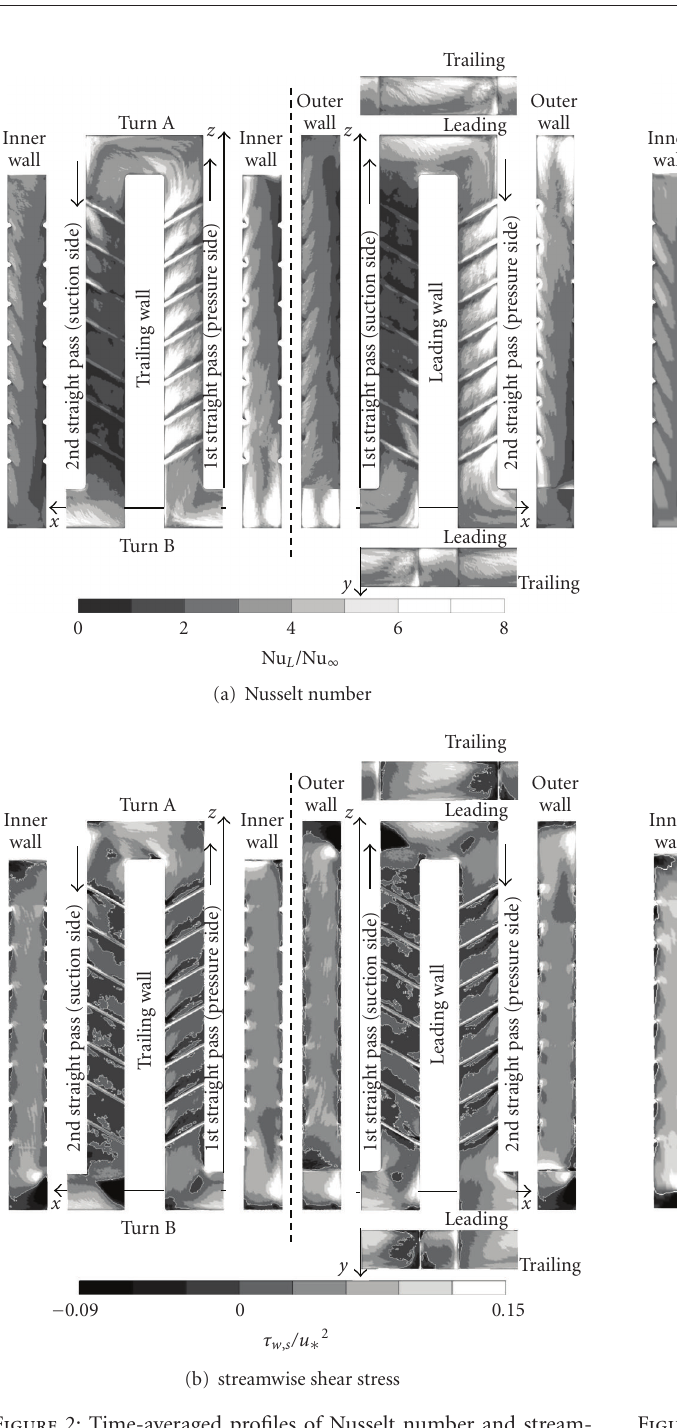
Figure 2: Time-averaged profiles of Nusselt number and stream- wise component of wall shear stress (60 ◦ rib NP, Re ∗ = 3000, Ro ∗ = 1, and Ra ∗ = 0).